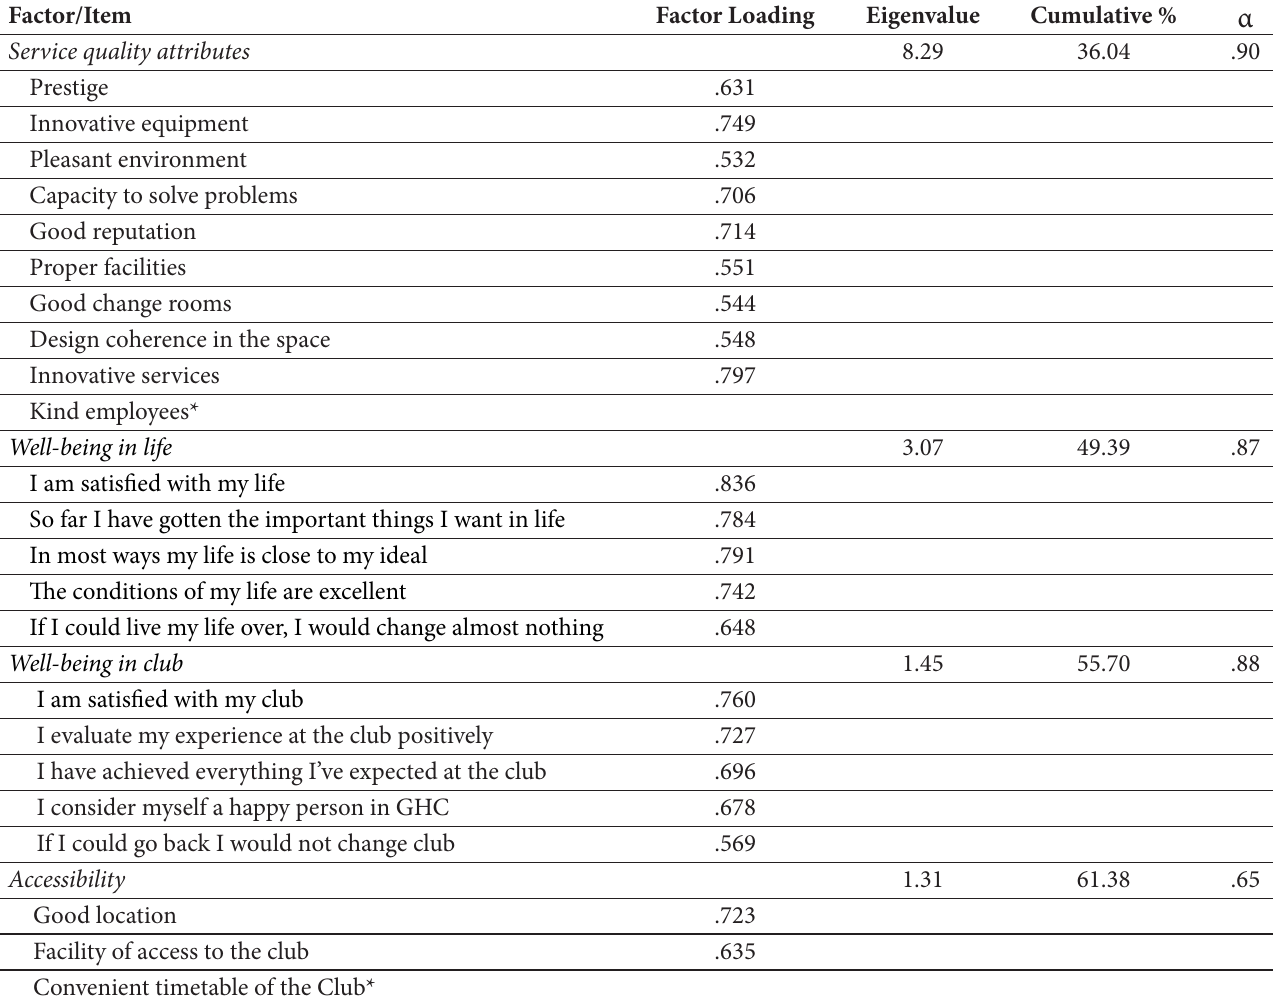
Table 1. Main results of the exploratory factor